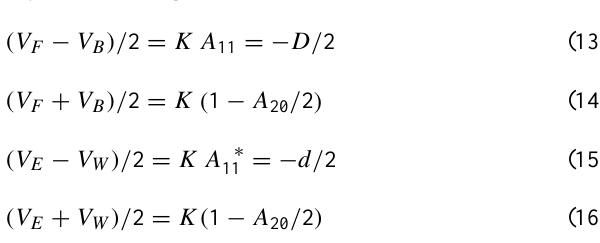
Fig. 1. A top view of the satellite spin quadrants, with the sun lo- cated to the right and the rotation counter